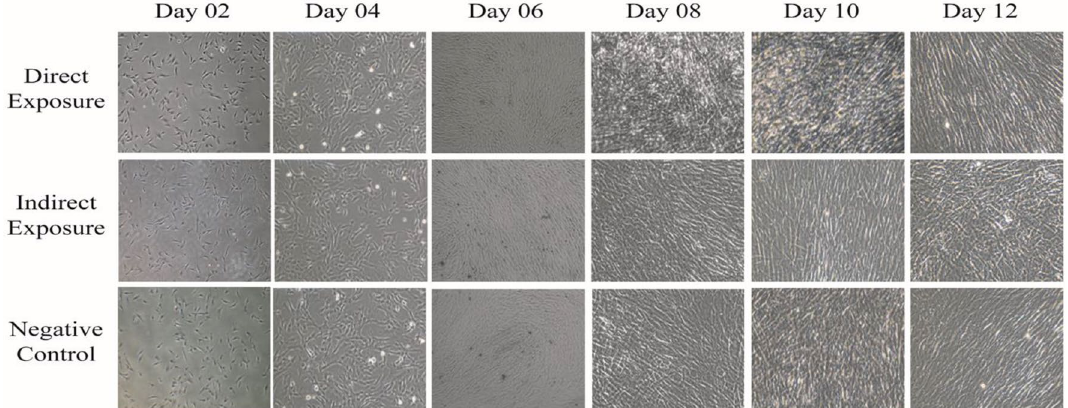
Figure 1. Morphological observations of the hUC-MSCs. Observation of cell morphology of the passage 3 hUC-MSCs in the DE, IE and NC groups. All cells exhibited the characteristic MSC fibroblast-like spindle shape with the DE group achieving 100% confluence at day 8 while the IE group with the least confluency even after day 10. The NC group achieved 100% confluence at day 10. All photo micrographs were taken using CKX41 Inverted Microscope (Olympus, Japan) with 100X